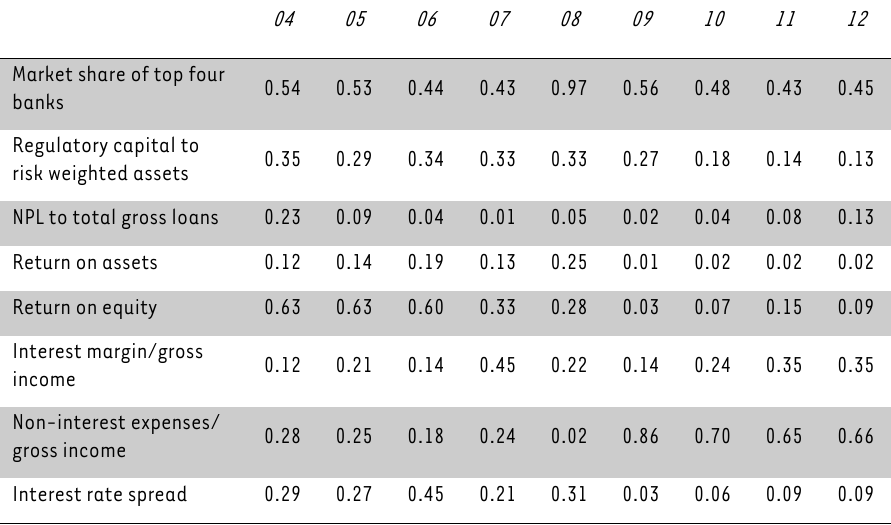
TABLE 1: Zimbabwe’s key financial indicators